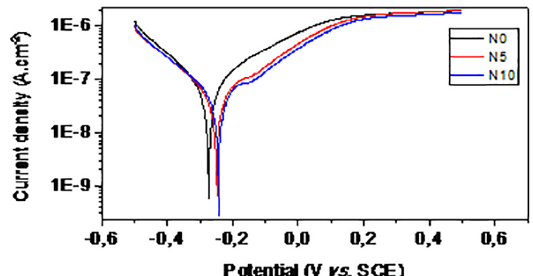
Figure 6. Potentiodynamic polarization curves for N0, N5 and N10 alloys obtained in 3.5